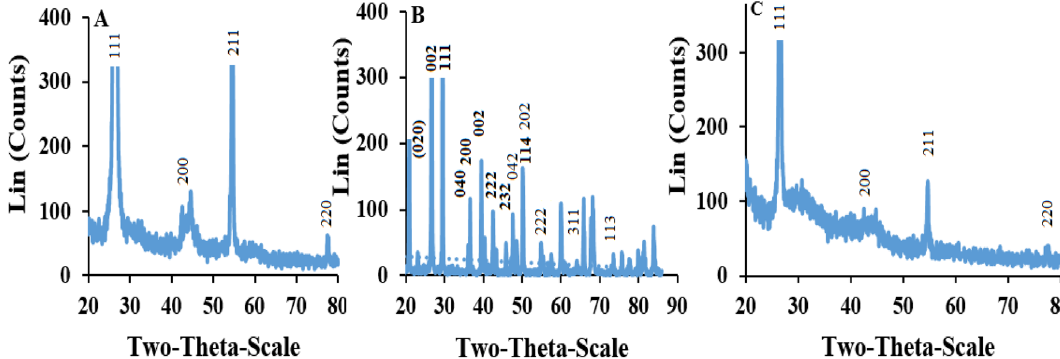
Figure 3. XRD patterns including ( A ) W filament, ( B ) WO 3 generated after introduction of humidity and ( C ) W-filament after the elimination of the memory effect. Conditions: standard RH: 40–45%, applied voltages: 110 ± 1 V (AC, vs. GND), and pressure: 25–30